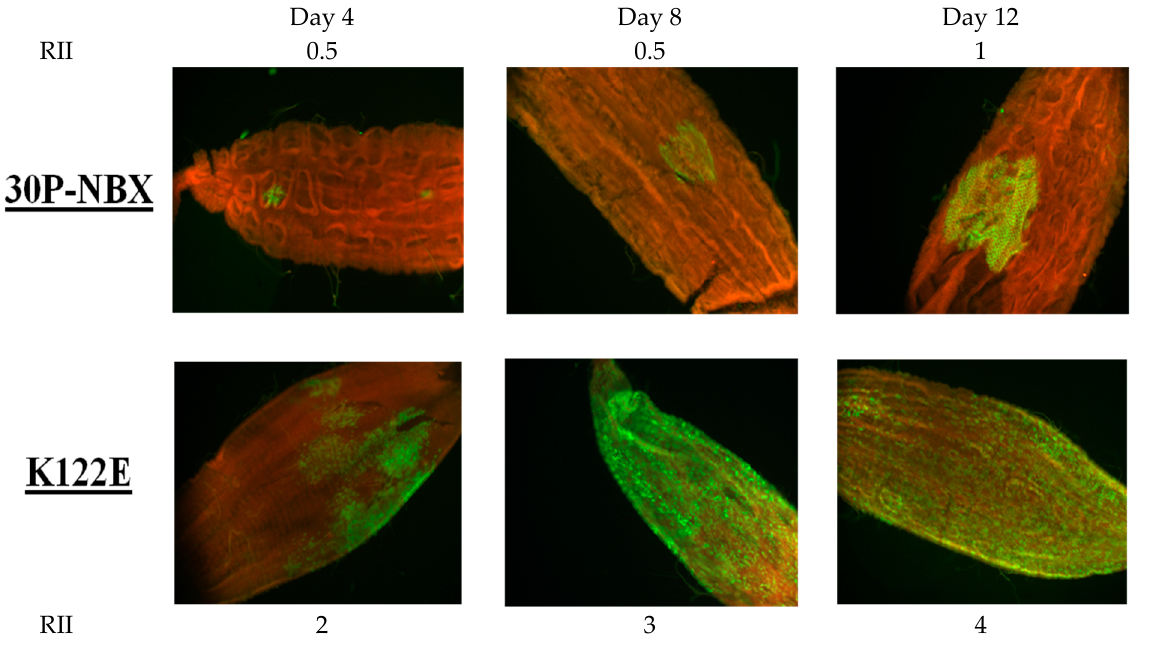
Figure 5. Demonstration of RII ratios in infected midguts from the time course experiment. RexD mosquitoes were orally challenged with 30P-NBX or K122E, midguts were dissected every other day for 14 days, and virus antigen was detected by IFA. Proportions of midguts displaying virus antigen (green) are representative of typical infection intensity seen for day 4 ( left ), day 8 ( middle ), and day 12 ( right ) PBM.